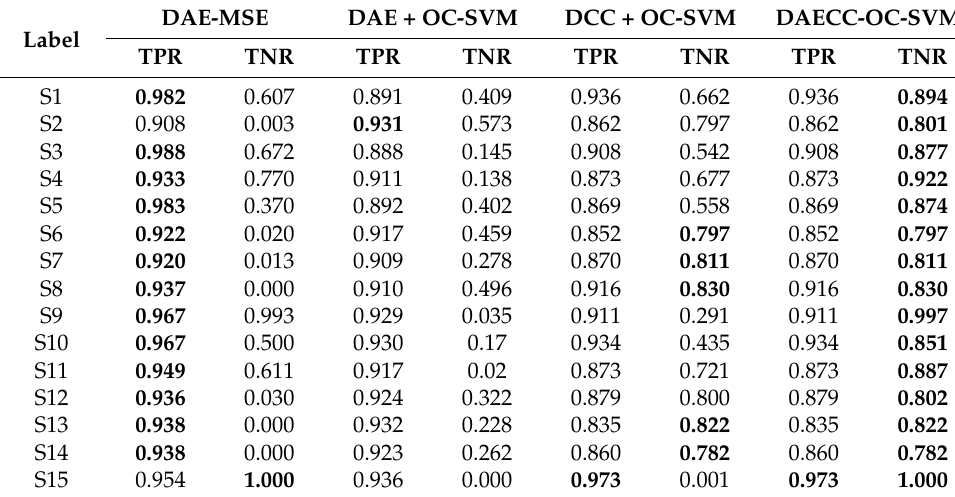
Table 3. Comparison of performance of anomaly detection in terms of TPR and TNR on multi-fault test bench.